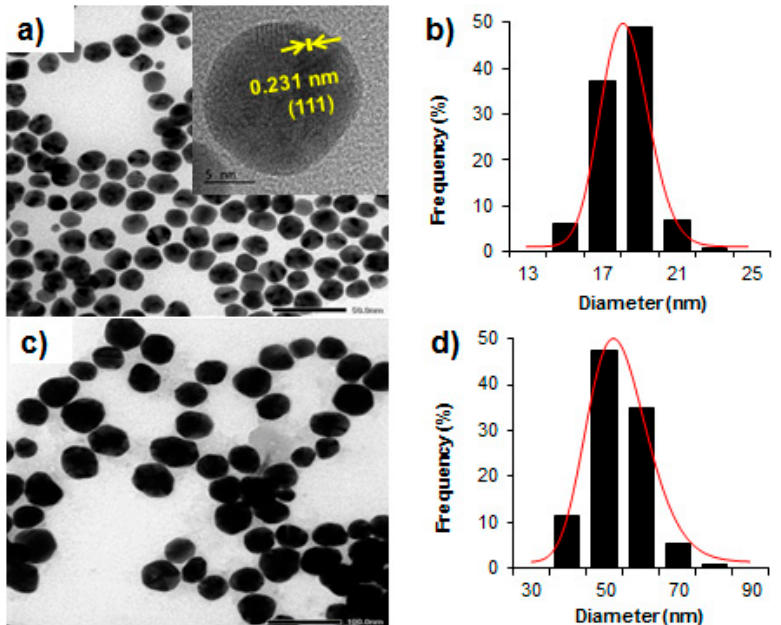
Figure 4. TEM image and particle size distribution of ( a , b ) Au nanoseeds, and ( c , d ) AuNSps. The inset: HRTEM image of Au nanoseeds.